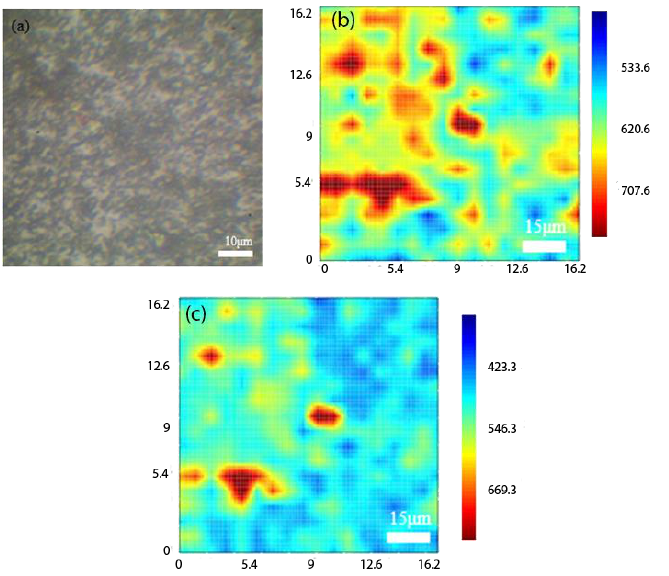
Figure 8. ( a ) OM image of MoS 2 /Cu 2 O, ( b ) 625 band for PL mapping image, ( c ) 675 band for PL mapping image. mapping